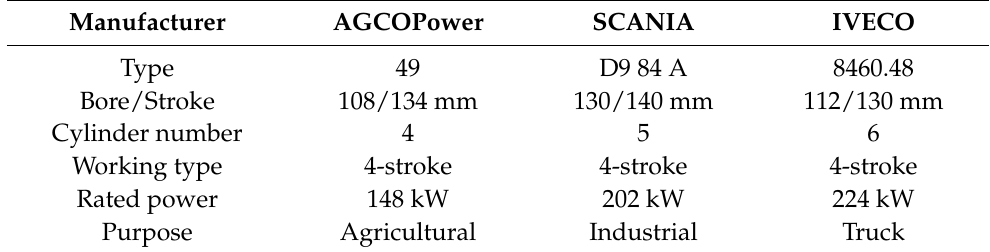
Table 4. Main specification of compared engines.